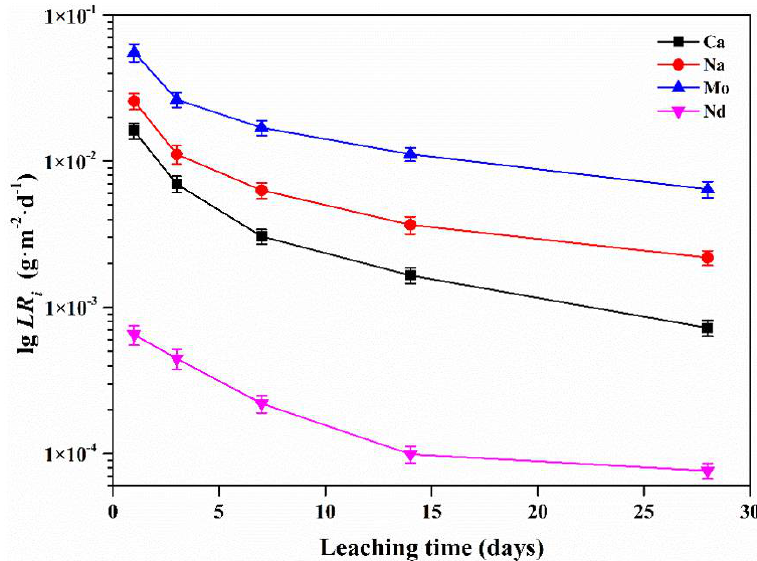
Figure 9. Normalized leaching rates of Na, Ca, Mo and Nd.